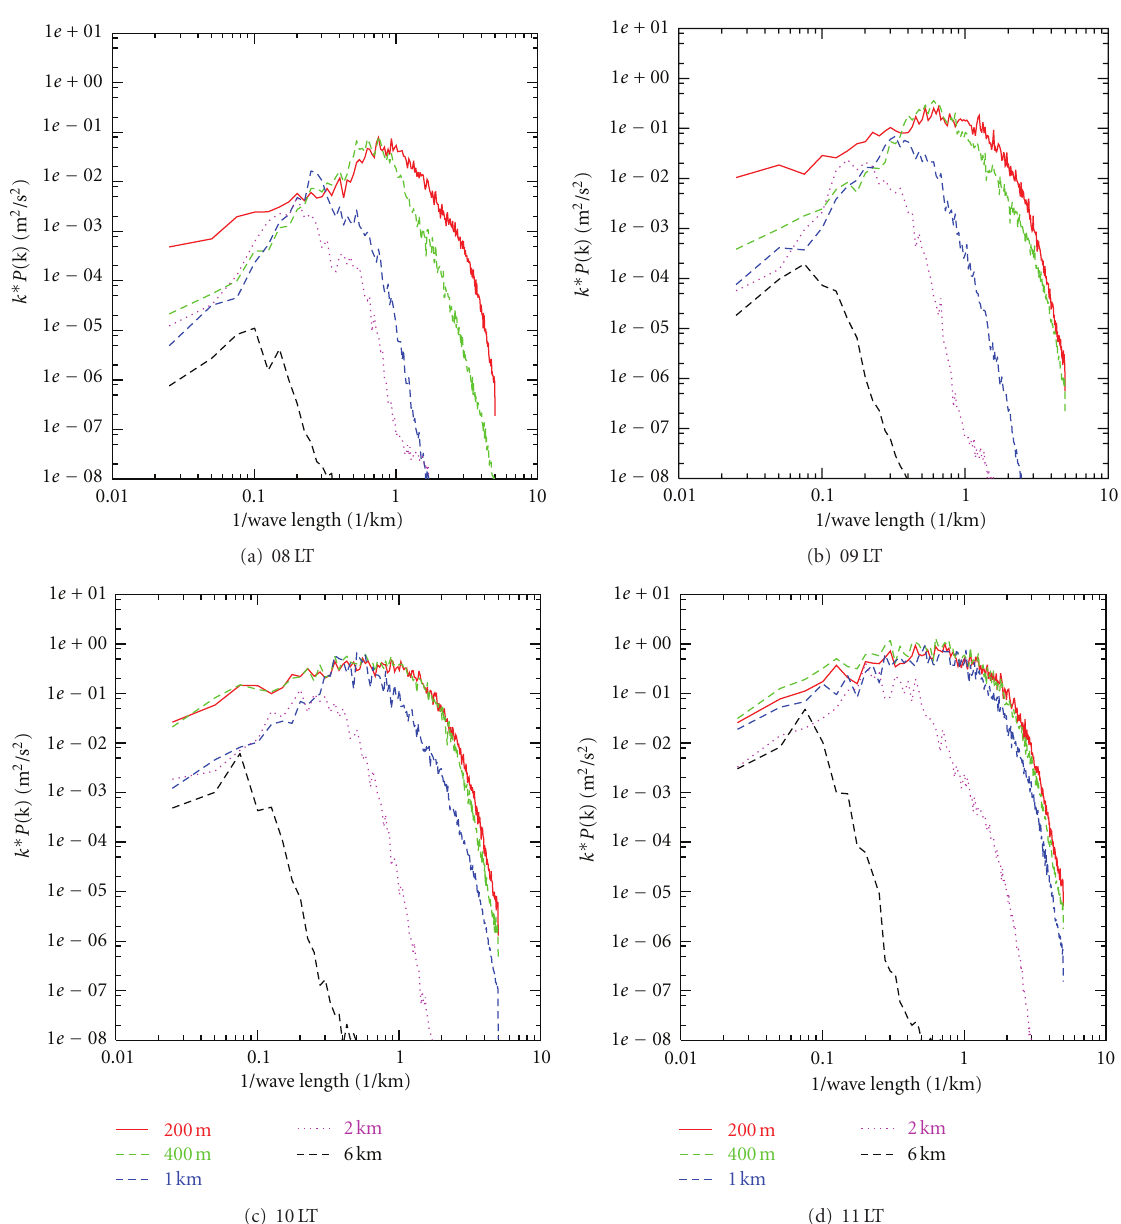
Figure 5: Power spectral density distribution for the x -direction variation of vertical velocity at five levels for EXP1 at (a) 0800 LT, (b) 0900 LT, (c) 1000 LT, and (d) 1100